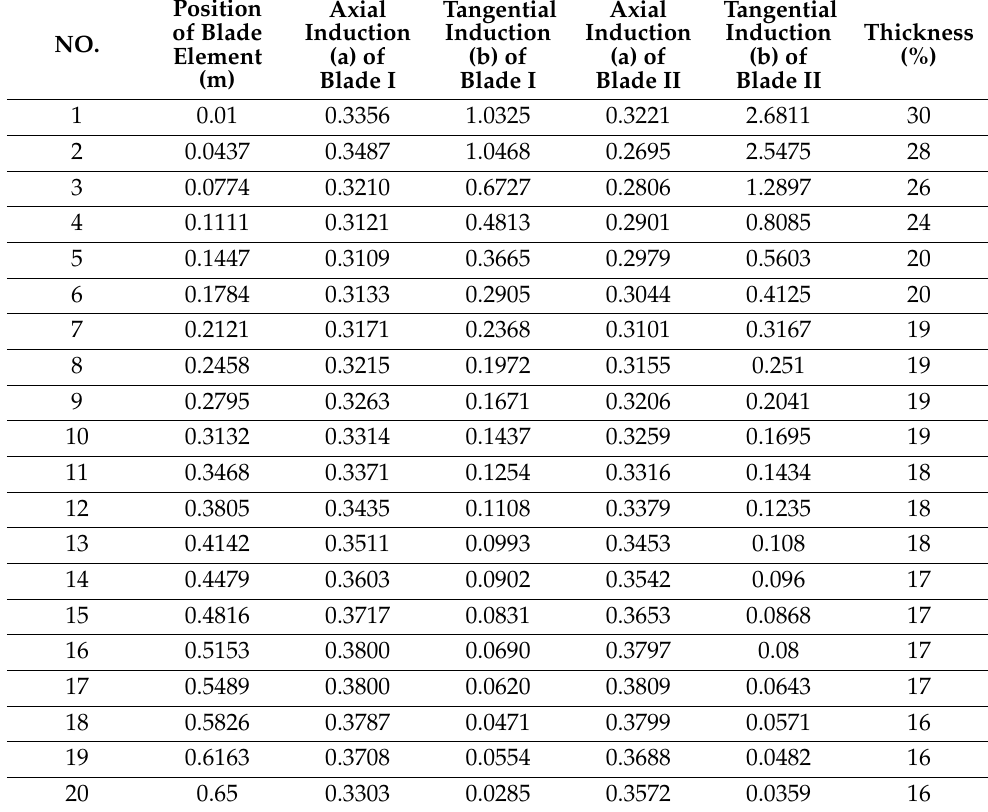
Table 3. Blade section